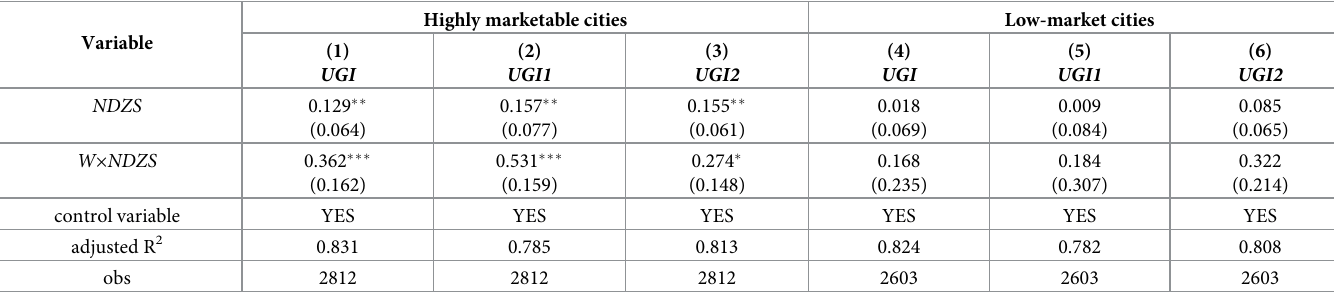
Table 6. Heterogeneity test: Highly marketable vs. low-market.